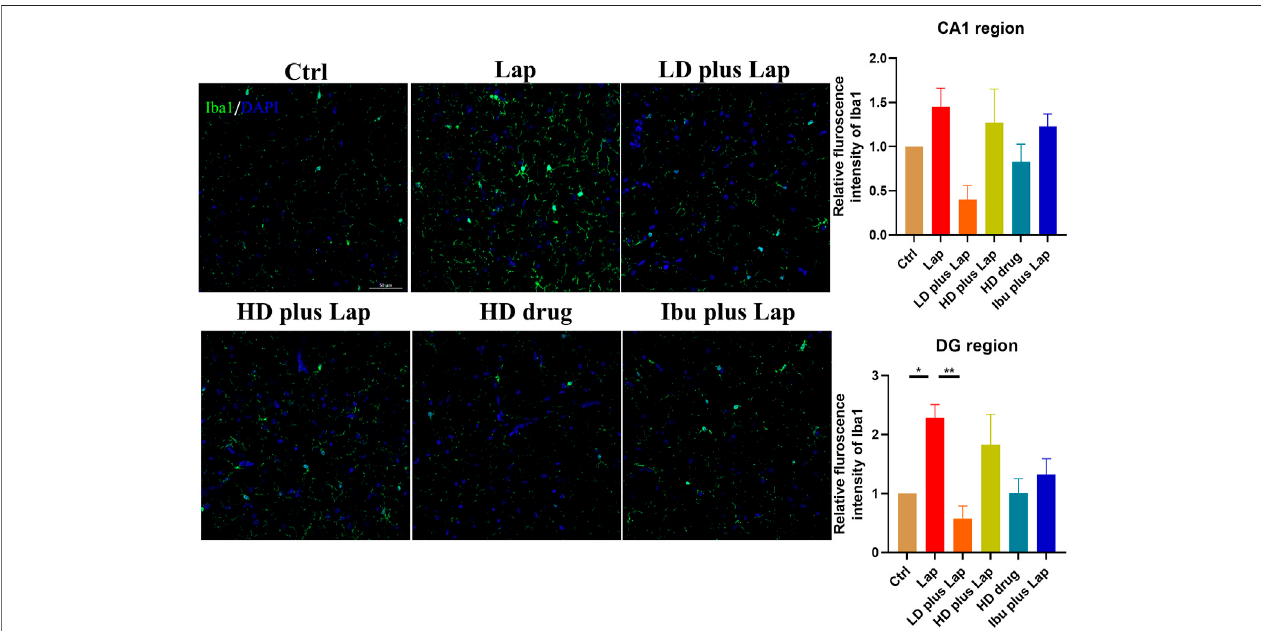
FIGURE 5 | D101 fraction reduced microglia activation in the hippocampus after surgery. Left panel shows the representative images of merged Iba1 and DPAI immuno fl uorescencesignalsinthehippocampus.Immuno fl uorescenceintensityofIba1inCA1andDGregionswasevaluatedbyconfocalmicroscopy.Up-regulationof Iba1 immuno fl uorescence signalswere observed intheDG region oflaparotomy group while D101treatmentreduced themicroglialactivationafter surgery.Scalebar = 50 µm. Data are presented as the mean and SEM ( n = 4). * p < 0.05, ** p < 0.01 compared with the laparotomy group. Values were analyzed by one-way ANOVA with Tukey post hoc